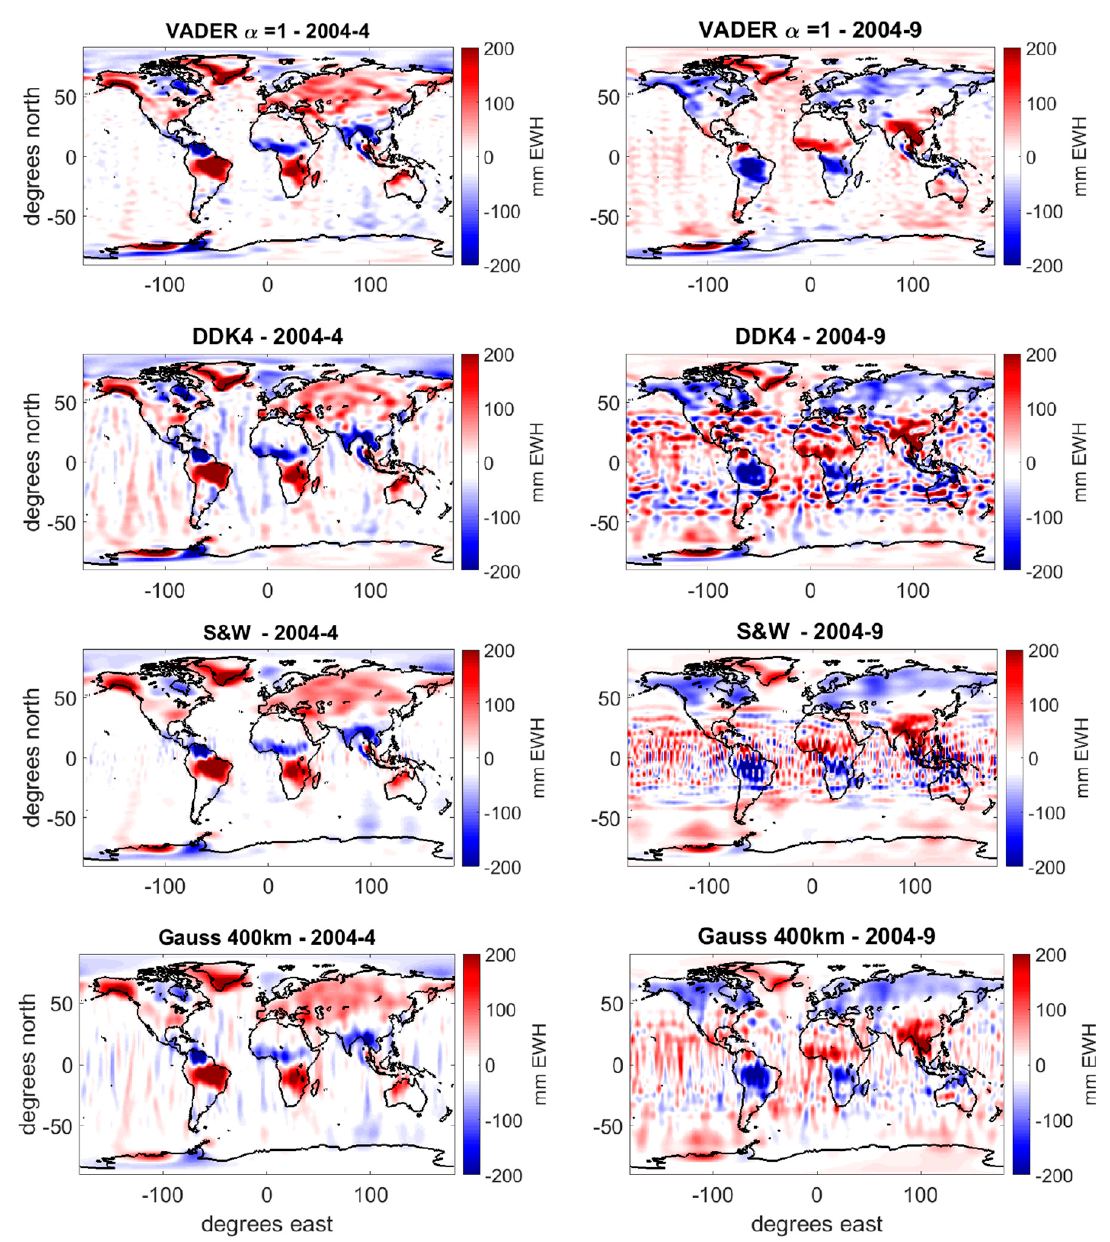
Figure 6. Example of real data (ITSG-Grace2014) filtering with different filter approaches for April 2004 ( left column) and September 2004 ( right column).